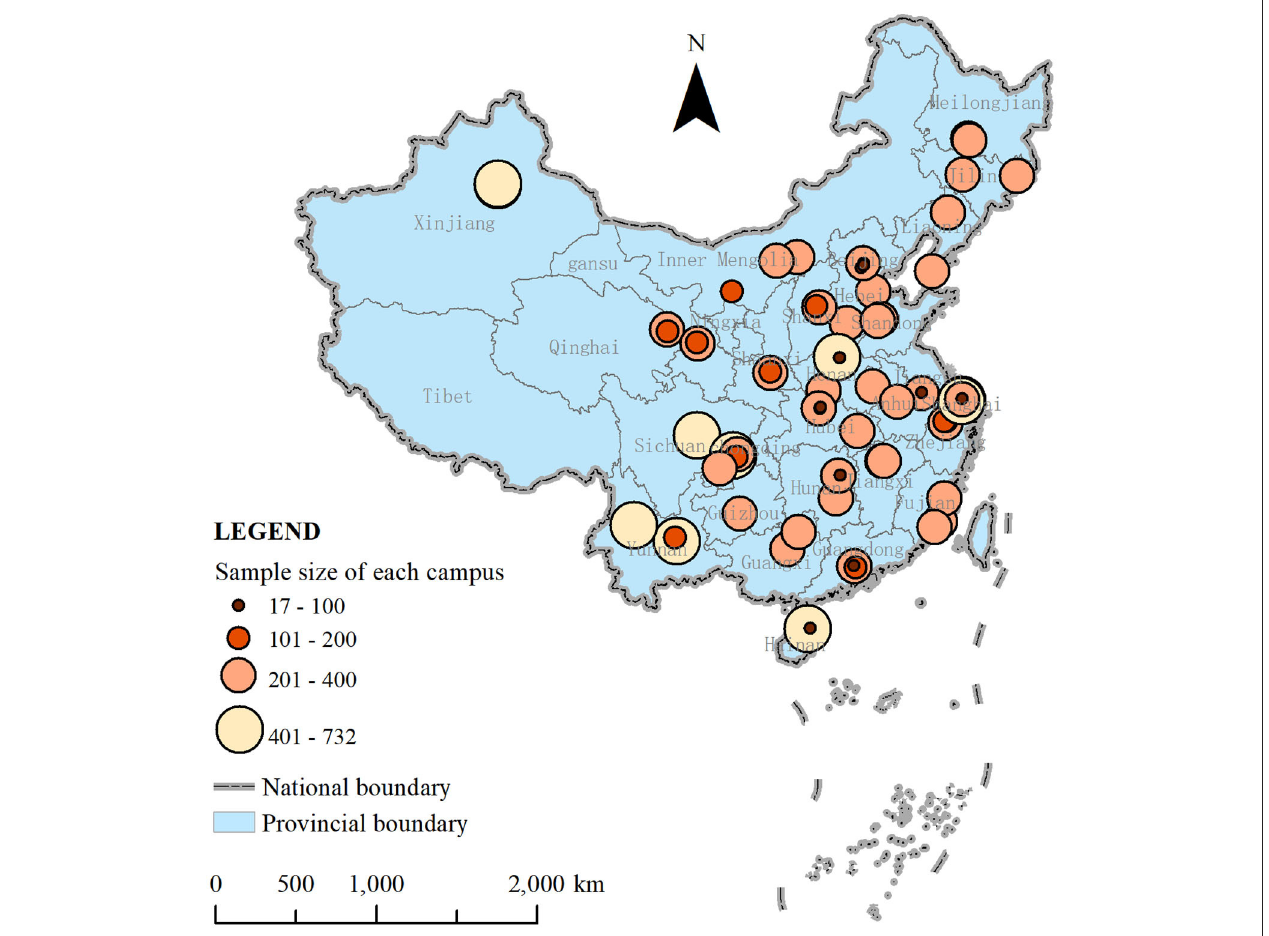
FIGURE 2 | Spatial distribution and sample size of the surveyed